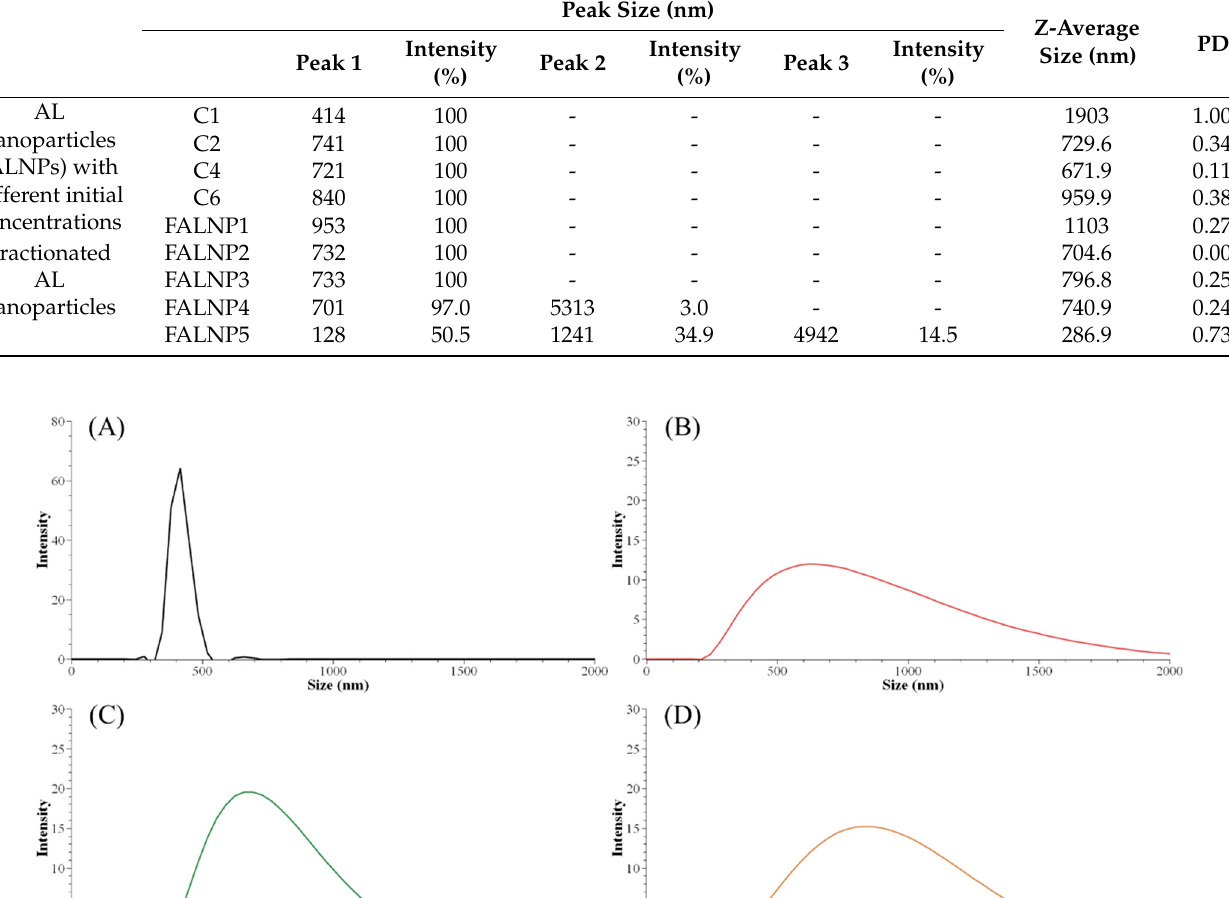
Table 5. Size properties of fractionated AL-derived nanoparticles.